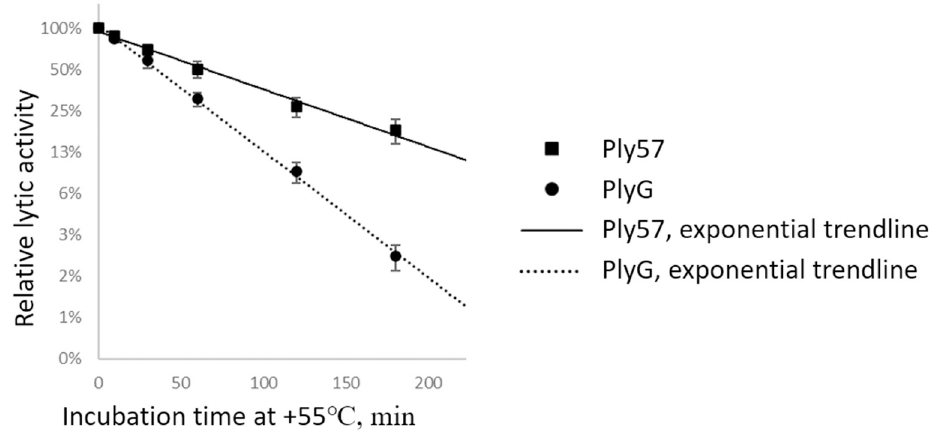
Fig 7. The thermal kinetic inactivation half-life experiment. Error bars indicate standard deviation values based on four replicates.